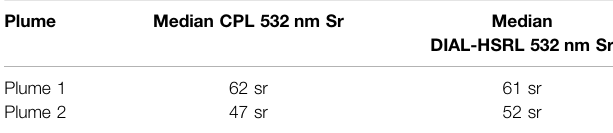
TABLE 6 | Comparison of CPL and DIAL-HSRL 532 nm lidar ratio values for the Williams Flats Fire.